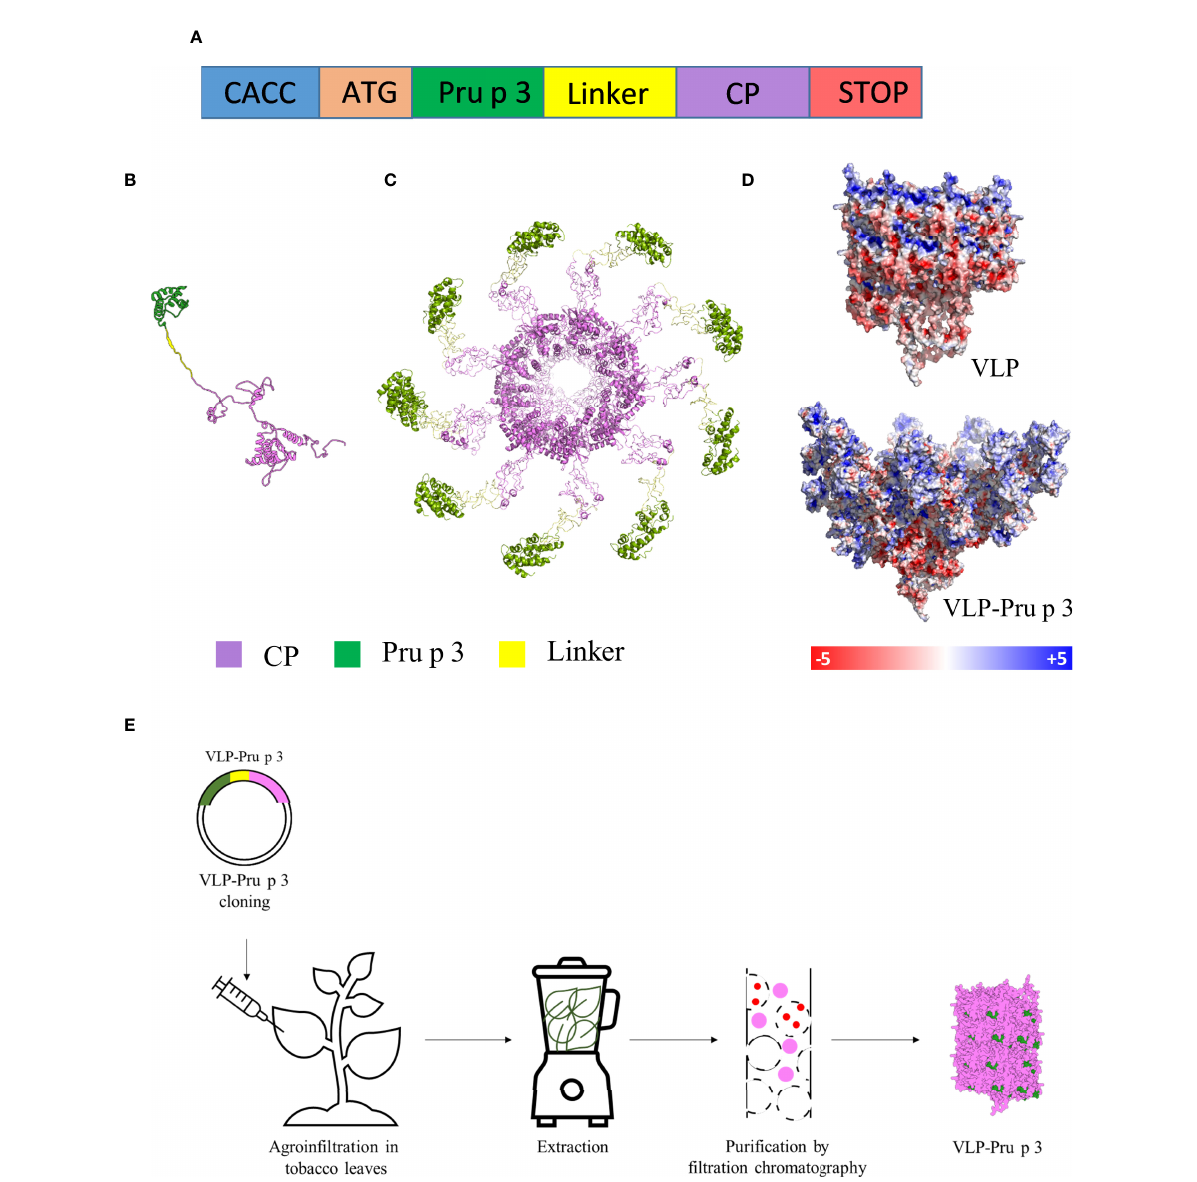
FIGURE 1 Production of VLP-Pru p 3. (A) Schematic representation of the synthetic genetic constructs coding for the recombinant fusion proteins to be expressed in plants. CACC sequence for directional cloning into the Gateway Entry vector. ATG initiation codon. Pru p 3 peach allergen sequence. Linker sequence to provide physical separation of Pru p 3 and CP. Two different linkers were tried. CP TuMV coat protein sequence. STOP codon. The relative lengths of the different modules in the constructs are not represented at scale. (B) Tertiary structure of the CP-Pru p 3 subunit as modelled by I-TASSER. (C) Quaternary structure of VLP-Pru p 3. (D) Poisson-Boltzmann electrostatic potential mapped onto the outer surface of VLP and VLP-Pru p 3. (E) Schematic diagram of VLP-Pru p 3 production and puri fi